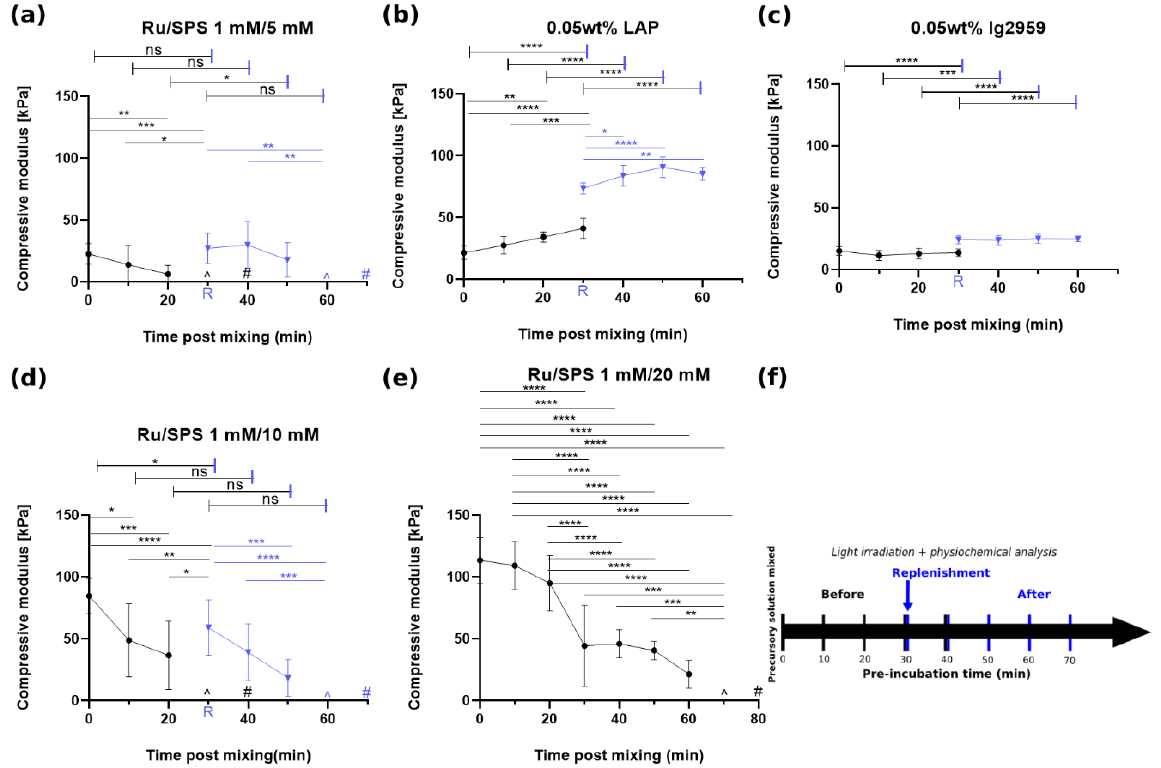
Figure 3. Mechanical strength of GelAGE versus pre-incubation time prior to crosslinking with flow chart, circle ( • ) represents crosslinking with designated time of pre-incubation and triangle ( ▼ ) represents the samples with further pre-incubation after replenishment of photoinitiator at t = 30 min: ( a ) 1 mM/5 mM Ru/SPS, ( b ) LAP, ( c ) Ig2959, ( d ) 1 mM/10 mM Ru/SPS and ( e ) 1 mM/20 mM Ru/SPS and ( f ) flow chart of the experiment. Values in the figures represent means and standard deviation of N = 9 replicates. Capped lines are for comparison with different groups (before and after replenishment) while straight lines are for comparison within the same group. Asterisks (*) represents values statistically significant at the p < 0.05 level, ** for p < 0.01, *** for p < 0.001 and **** for p < 0.0001. Pound (#) sign represents no-gel formation and (^) represents non-measurable. ns represents values statistically non-signigicant.